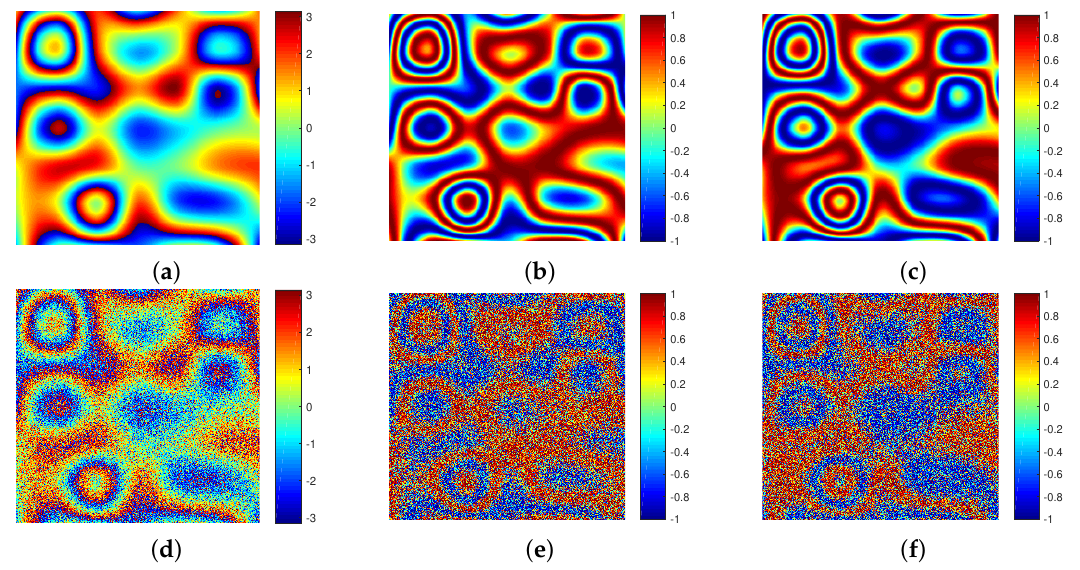
Figure 9. Simulated interferometric phase. ( a ) Clean interferometric phase , and its ( b ) real part and ( c ) imaginary part. ( d ) Noisy version of ( a ), and its ( e ) real part and ( f ) imaginary